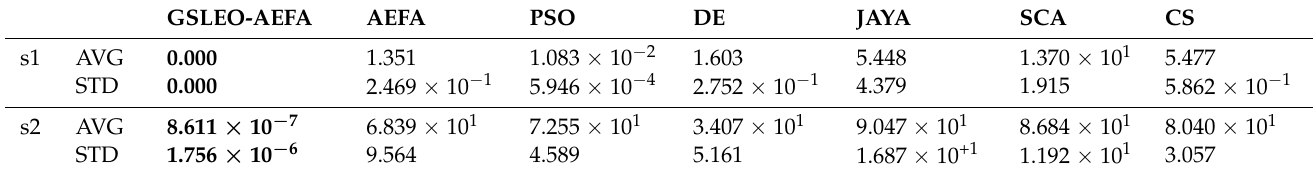
Table 12. Results of antenna S-parameter optimization problem, significant values are in bold.